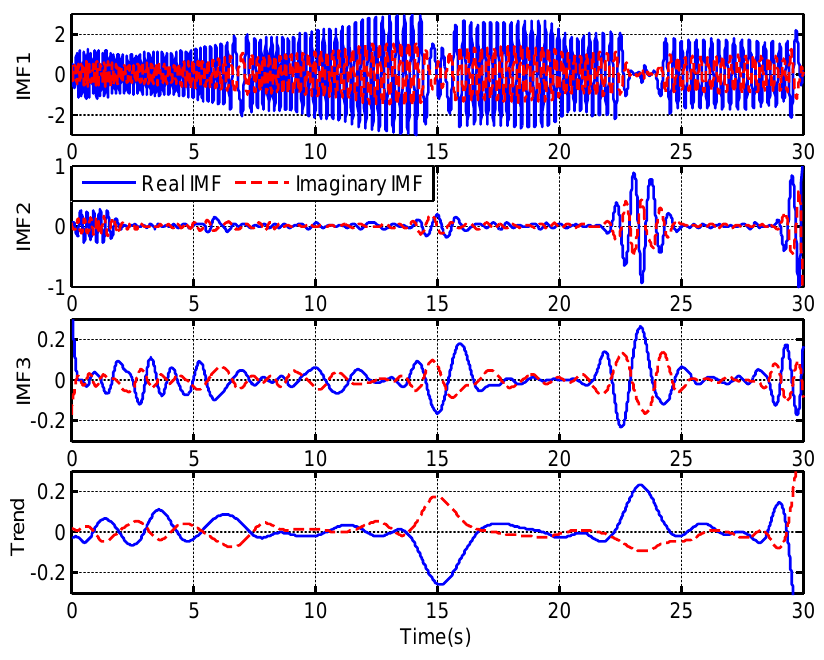
Figure 13. The true IMFs of experimental chatter signal.